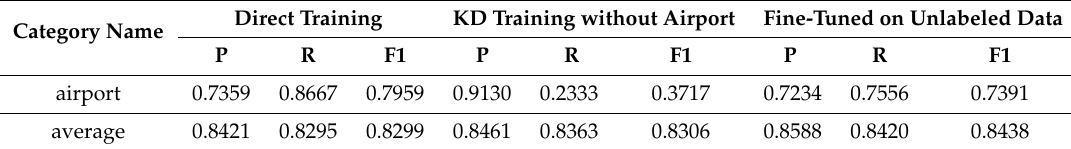
Table 5. Results of Knowledge Distillation training experiments on AID dataset without Airports.